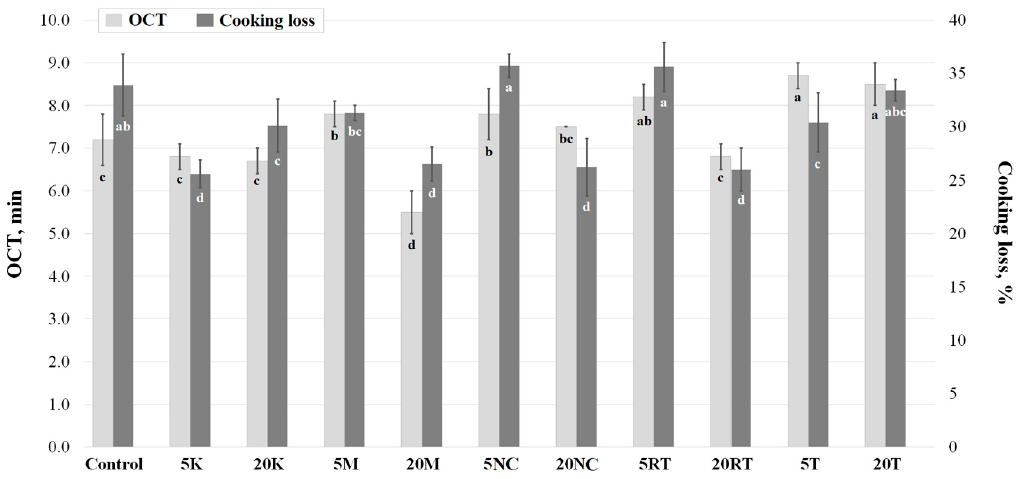
Figure 3. Optimal cooking time (OCT) and cooking loss of buckwheat-based pasta containing 5 or 20% quinoa varieties. Different letters indicate significant difference at level p of 5%. Corresponding dataset in Supplementary Materials (Table S2). Error bar shows ± standard deviation.